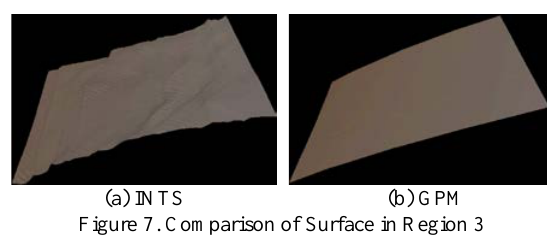
Figure 6. Comparison of Surface in Region 2